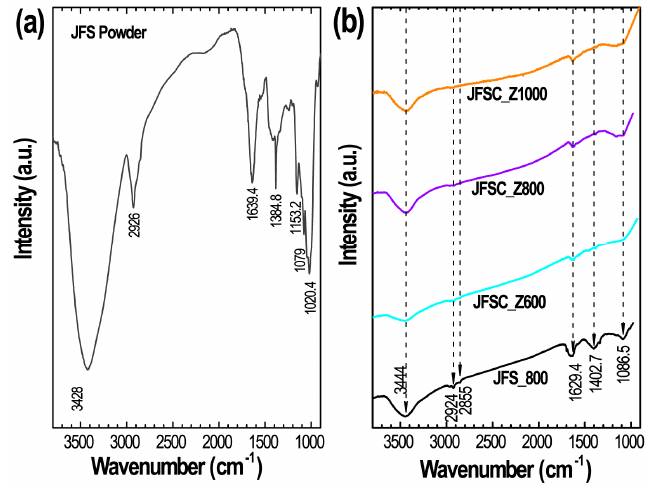
Figure 3. ( a ) FTIR spectrum of Jackfruit seed precursor recorded at 25 °C. ( b ) FTIR spectra of derived carbons JFS_800, JFSC_Z600, JFSC_Z800 and JFSC_Z1000 recorded at 25 °C.